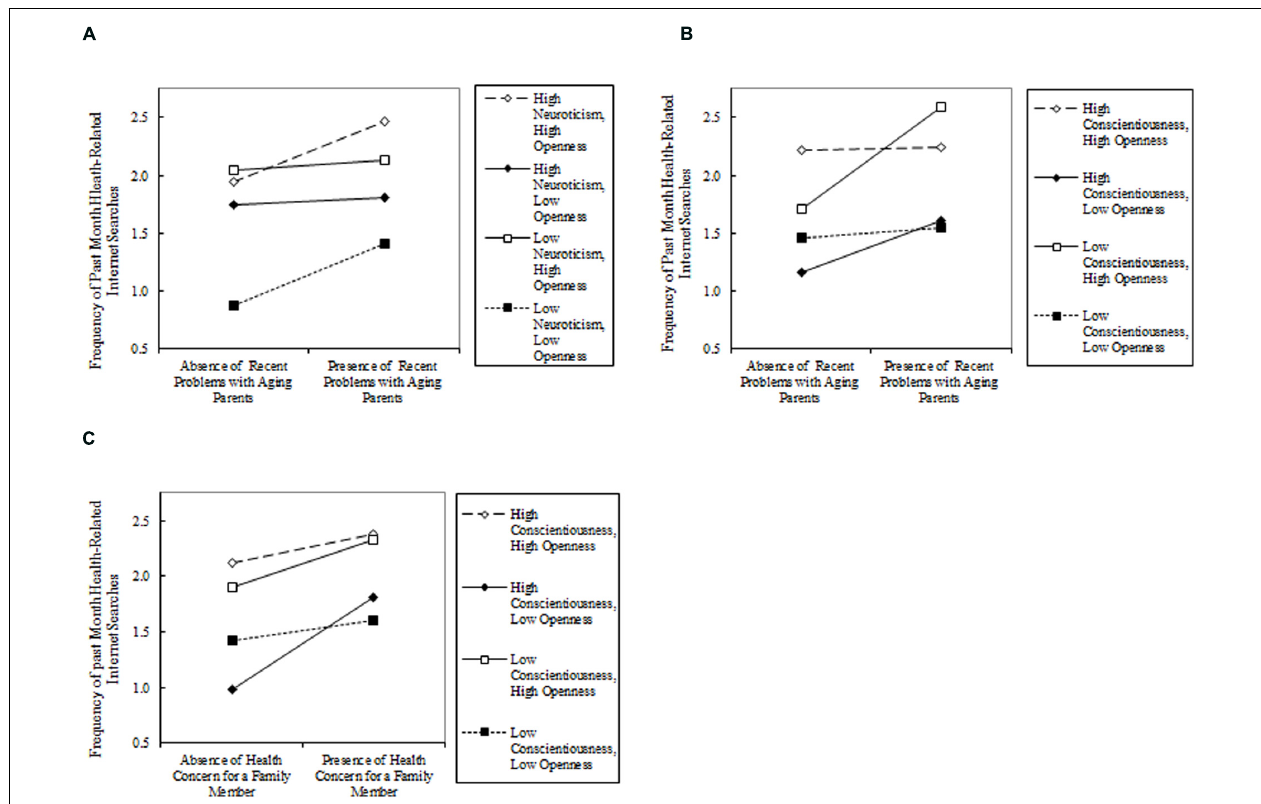
past-month problems with aging parents in the prediction of past-month health-related Internet searches. (C) depicts the three-way interaction among high and low ( + / − 1 standard deviation) levels of openness, conscientiousness, and the absence/presence of past-month health concerns for a family member in the prediction of past-month health-related Internet